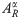
Schematic representation of the construction of the feature vector for each band and index.For each pair of channels as in (a), the raw data in (b) are filtered in the electrodes (Fp1 and T3 in this example), segments such as those in (b) are selected. Then, the signals are filtered in the corresponding frequency bands (e.g., α in (c)), and the 8×8 connectivity matrix ARα is obtained, which is finally converted to the 1 × 28 feature vector, after removing the diagonal elements and taking into account the symmetry of both PS indices (i.e., aRiib=1;aRilb=aRlib ∀i, l, b and R).